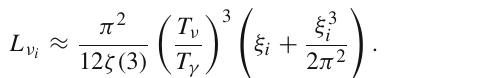
of the inhomogeneity goes down and it spreads out in